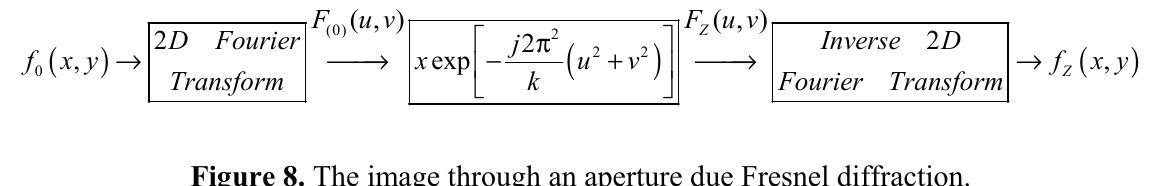
Figure 8. The image through an aperture due Fresnel diffraction.